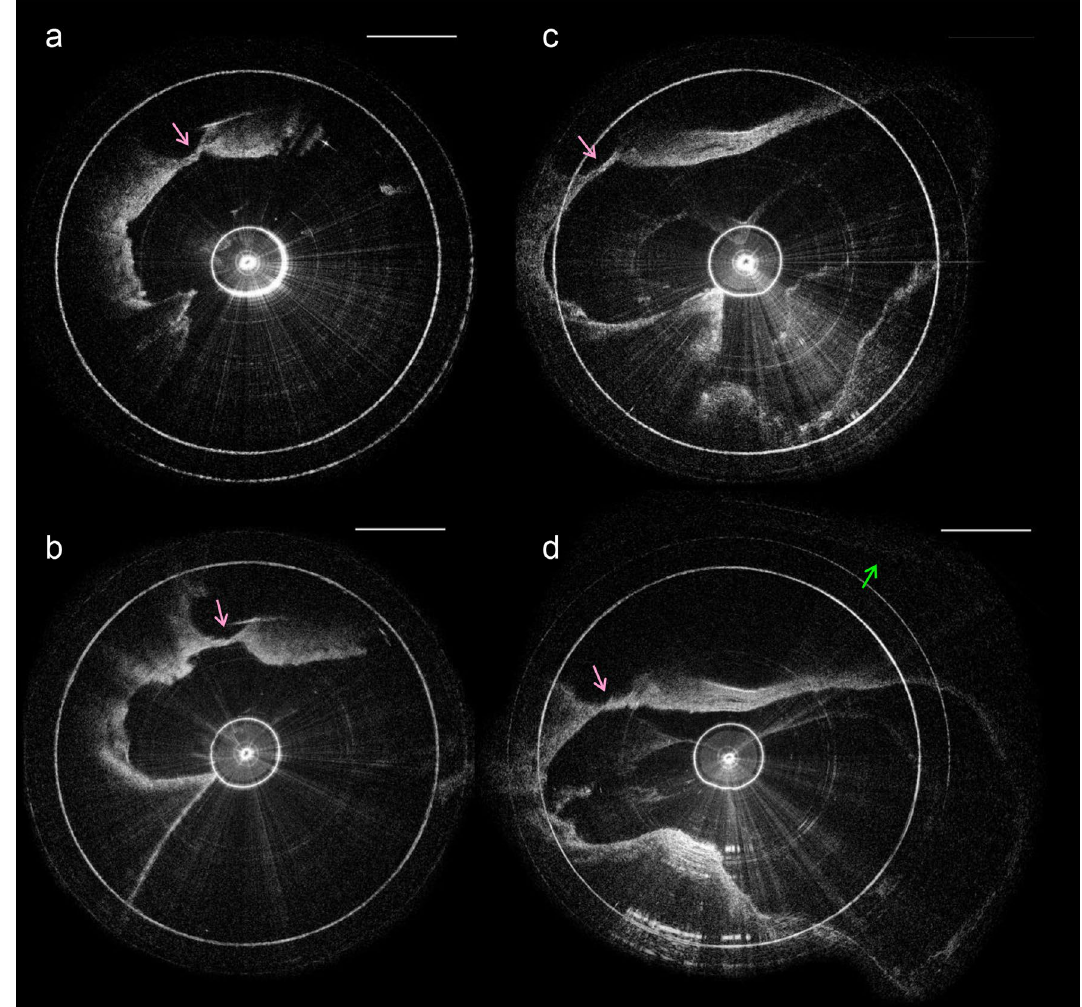
Figure 5. Four circularized μOCT images of the human cochlea’s interior, acquired using an intracochlear μOCT endoscope. The 2D images depicted in ( a–d ) were acquired at sequentially increasing distances from the round window. The magenta arrow in each panel indicates the location of the organ of Corti. The green arrow in panel d indicates the upper boundary of scala vestibuli. All scales = 50